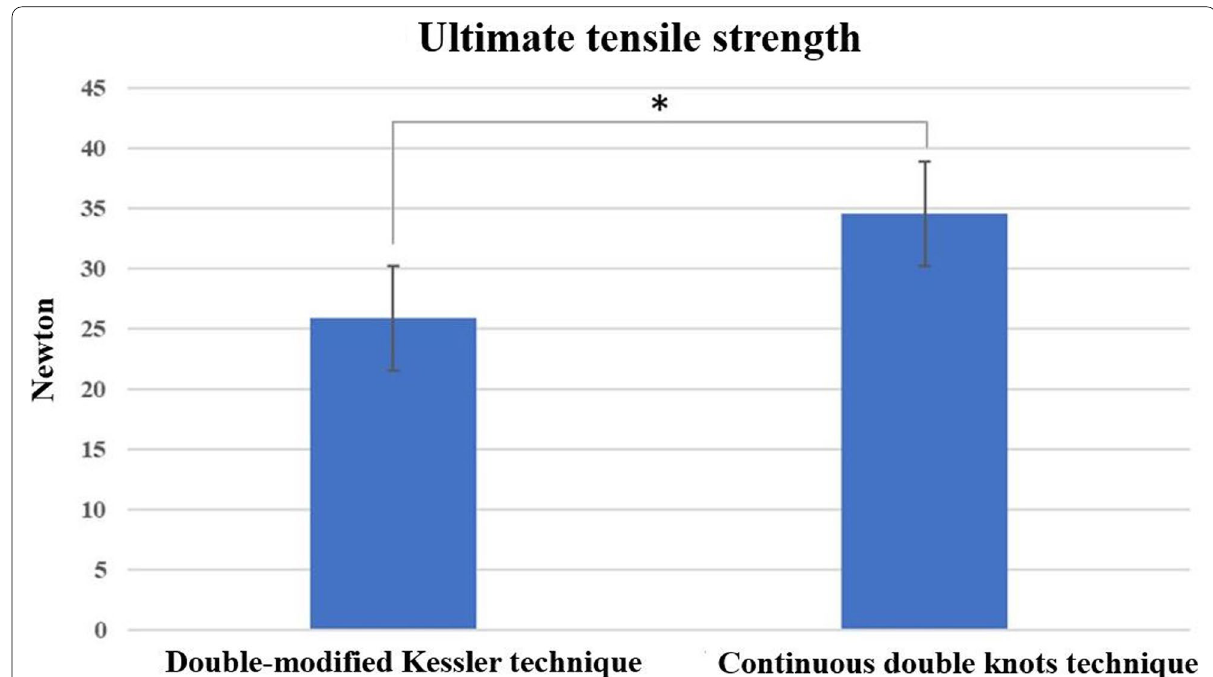
Fig. 5 Comparison of ultimate tensile strength shown for each tendon repair technique. The difference between the double-modified Kessler technique and the continuous double knots technique was statistically significant